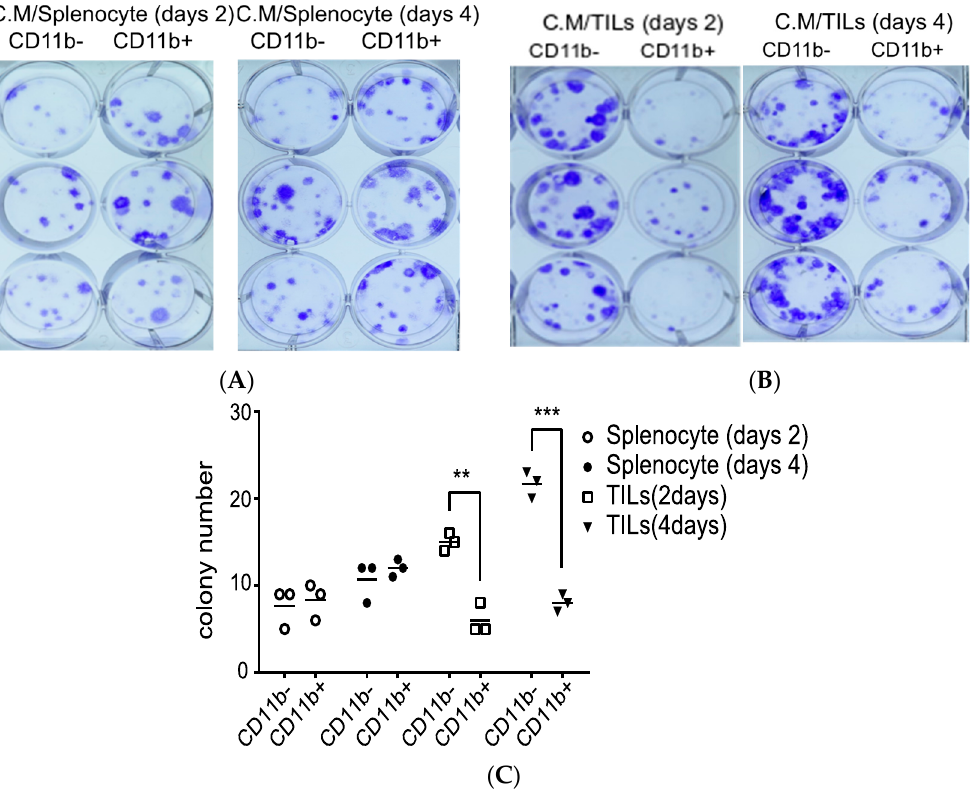
Figure 3. Proliferation effects of the secreted factors in conditioned media from cluster of differentiation 11b (CD11b)-deficient tumor-infiltrating leukocytes (TILs/CD11b − ). ( A ) Colony-formation assays using conditioned media from CD11b − and CD11b + leukocytes enriched from splenocytes. Conditioned media were collected at different times (Days 2 and 4) and applied to transgenic adenocarcinoma of the mouse prostate (TRAMP)-C1. ( B ) Similar to panel A, conditioned media were collected from TILs enriched from TRAMP-C1-derived tumors. ( C ) Comparison of colony numbers in TRAMP-C1 cells incubated with conditioned media derived from either CD11b − or CD11b + leukocytes. Measurements were derived from three replicates, and results are presented as the mean ± SD. Student’s t -test. ** p < 0.01, *** p < 0.001.